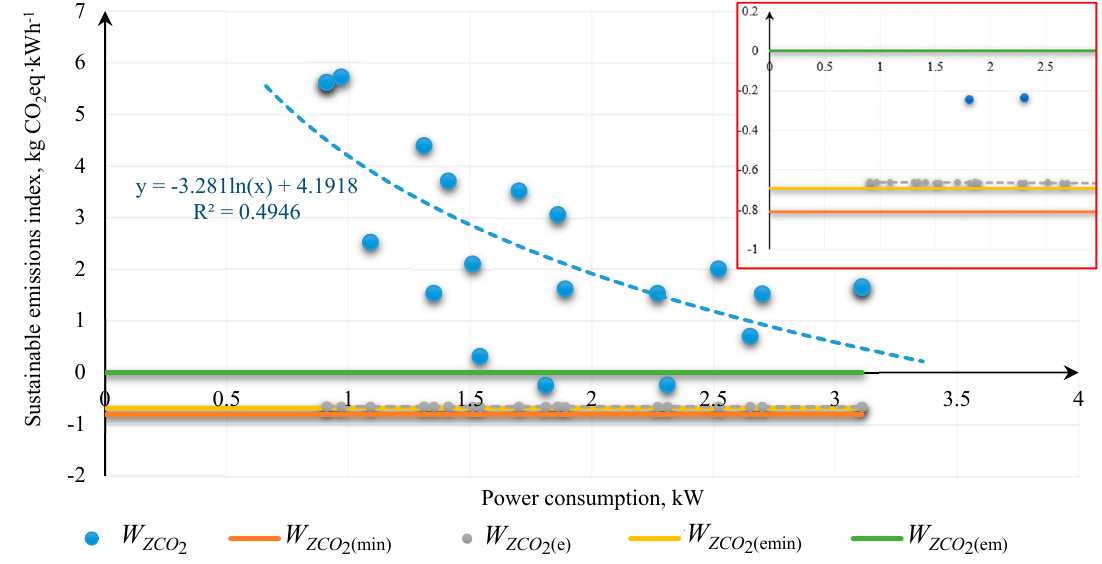
Figure 7. Sustainable CO 2 emissions index for corn grinding on a multi-disc grinder in a function of power consumption.